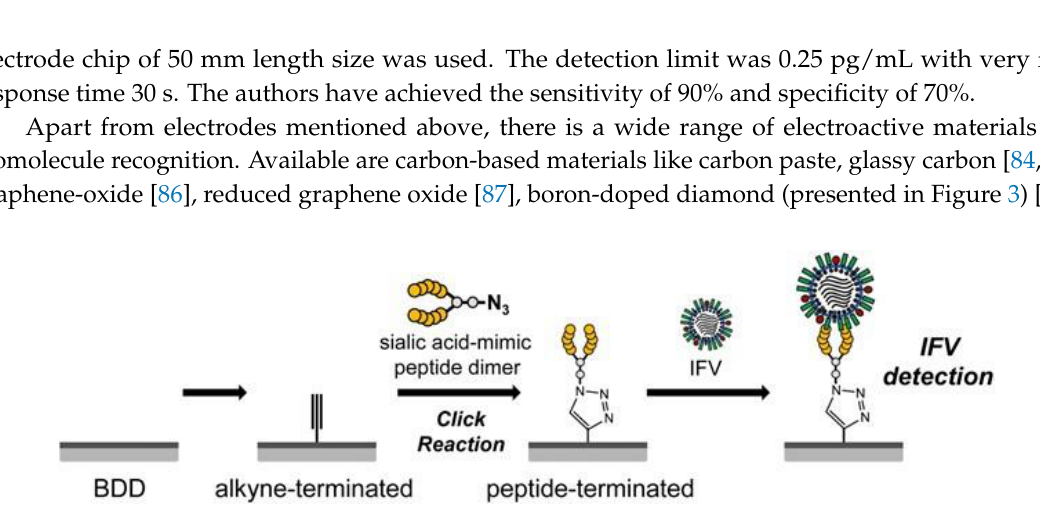
Figure 3. An example of electrode surface modification. Boron-doped diamond electrode modified via click reaction for infectious flacherie virus (IFV) electrochemical detection. Reproduced with permission from Matsubara et al., PNAS; published by PNAS, 2016.